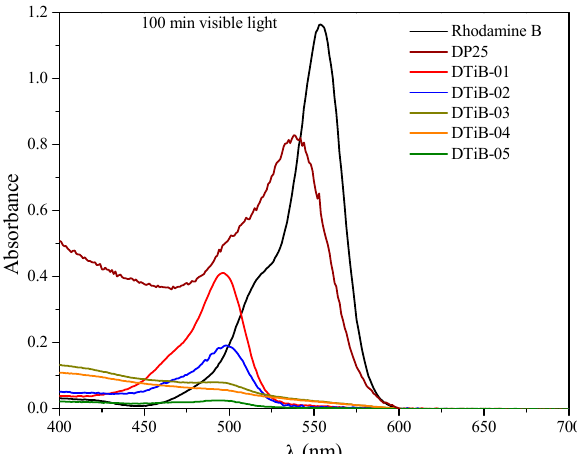
Figure 10. UV-Vis spectra for the remaining Rhodamine B solutions after a 100 min exposure to visible light.